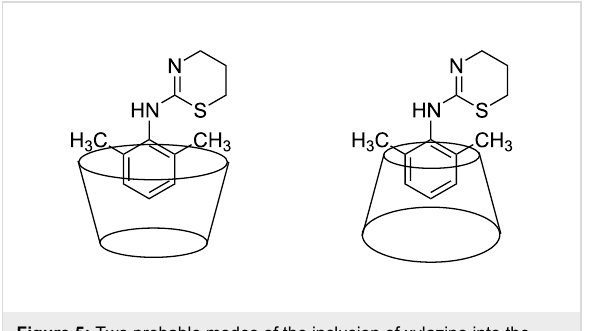
Figure 5: Two probable modes of the inclusion of xylazine into the β -CD cavity.